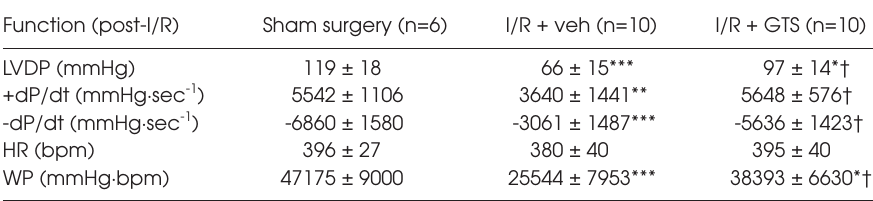
Table 2. Myocardial contractile function measured in vivo in a rat model of